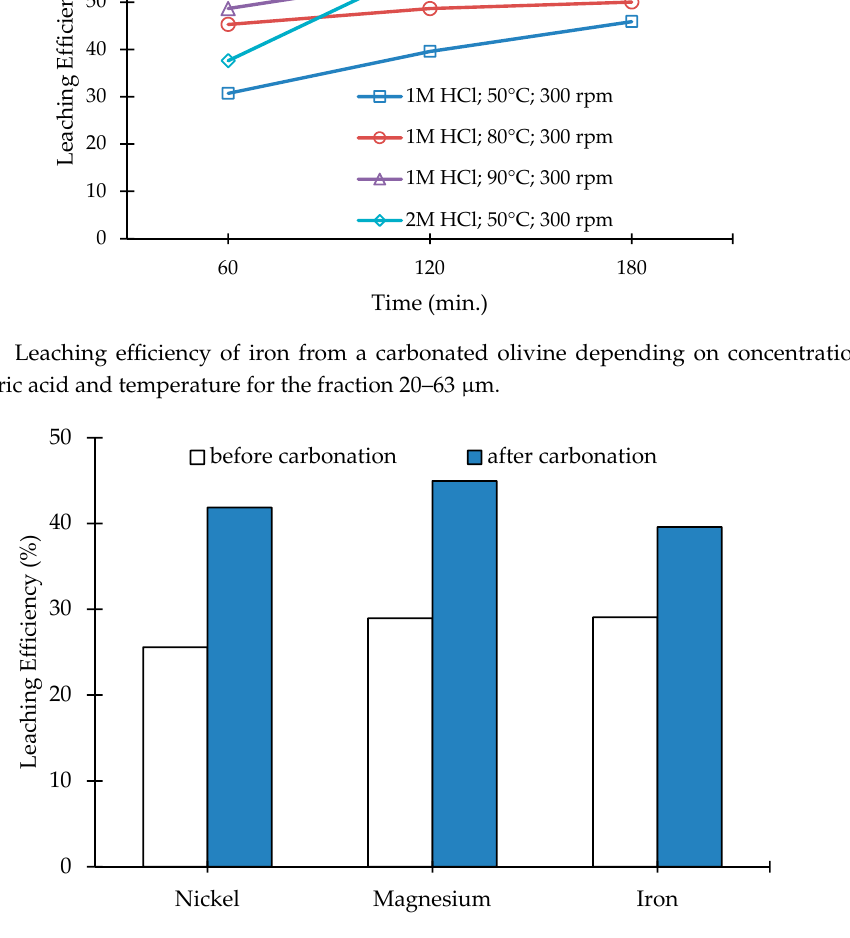
Figure 14. Comparison of the leaching efficiency of olivine without carbonation and with olivine with carbonation as a pre-treatment step, 20–63 µ m, 50 ◦ C, 120 min, 1M HCl and 300